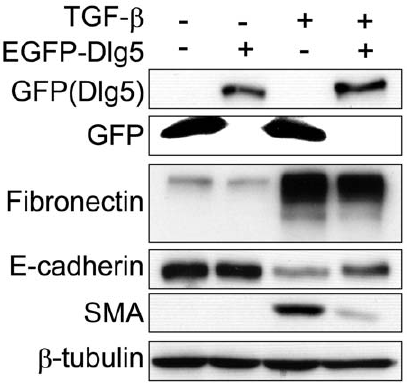
Figure 3. Overexpression of Dlg5 attenuates the TGF- b - mediated increase in the expression of mesenchymal marker proteins. LLc-PK1 cells stably expressing GFP or GFP-tagged Dlg5 were treated with or without 4 ng/ml TGF- b . After two days of incubation, cells were lysed and protein expression was detected by immunoblot- ting using the indicated antibodies. Exogenously expressed Dlg5 suppressed the increase in SMA and fibronectin expression.